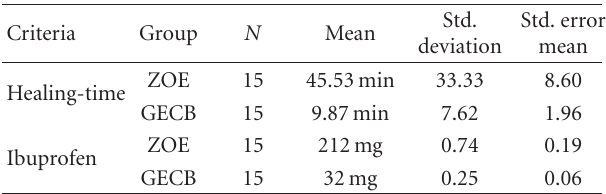
Table 2: Healing time and ibuprofen intake compared between the two